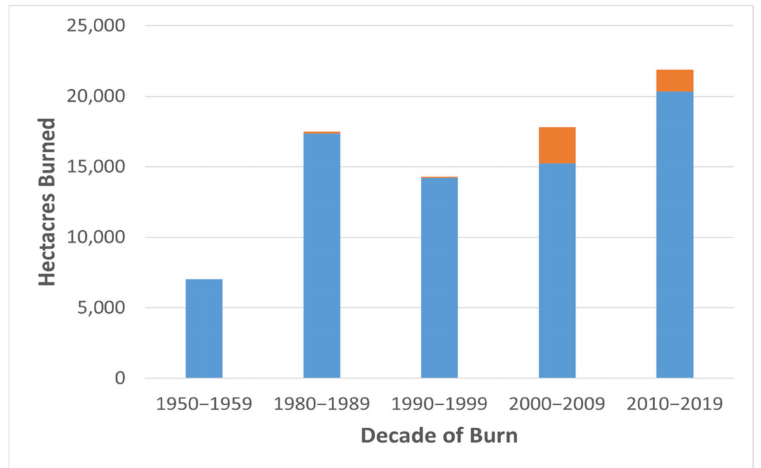
Area burned by decade on the Tetlin National Wildlife Refuge from 1940–2020. The 1940–1949 decade is not included because no fires occurred. Reburned area with <40 years since last burn is orange and mature forest area burned is